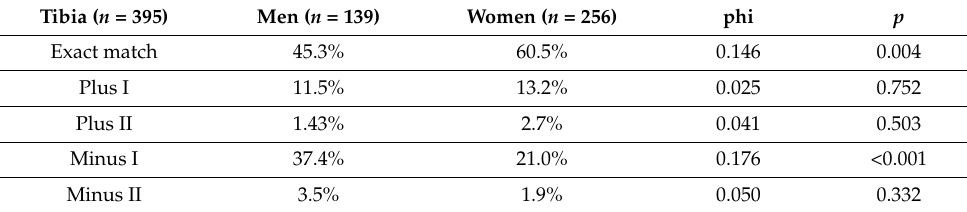
Table 3. Tibial planning adherence and sex; (value of significance from Fischer’s exact